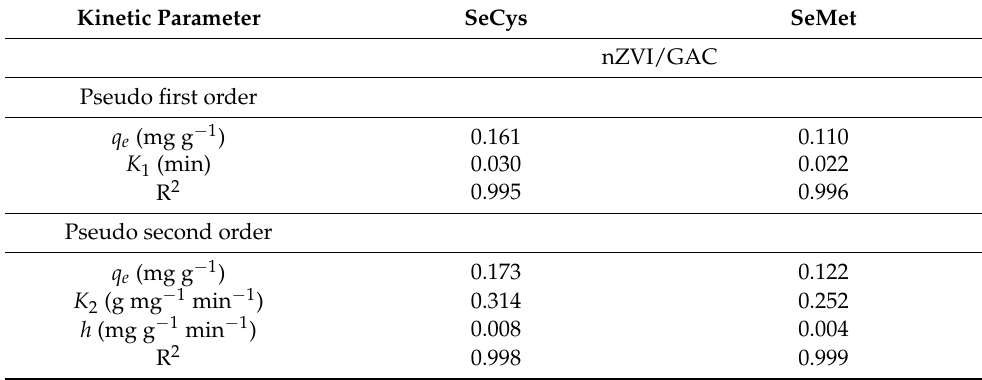
Table 4. PSO and PFO kinetic data for SeCys and SeMet adsorption by nZVI/GAC. Kinetic Parameter